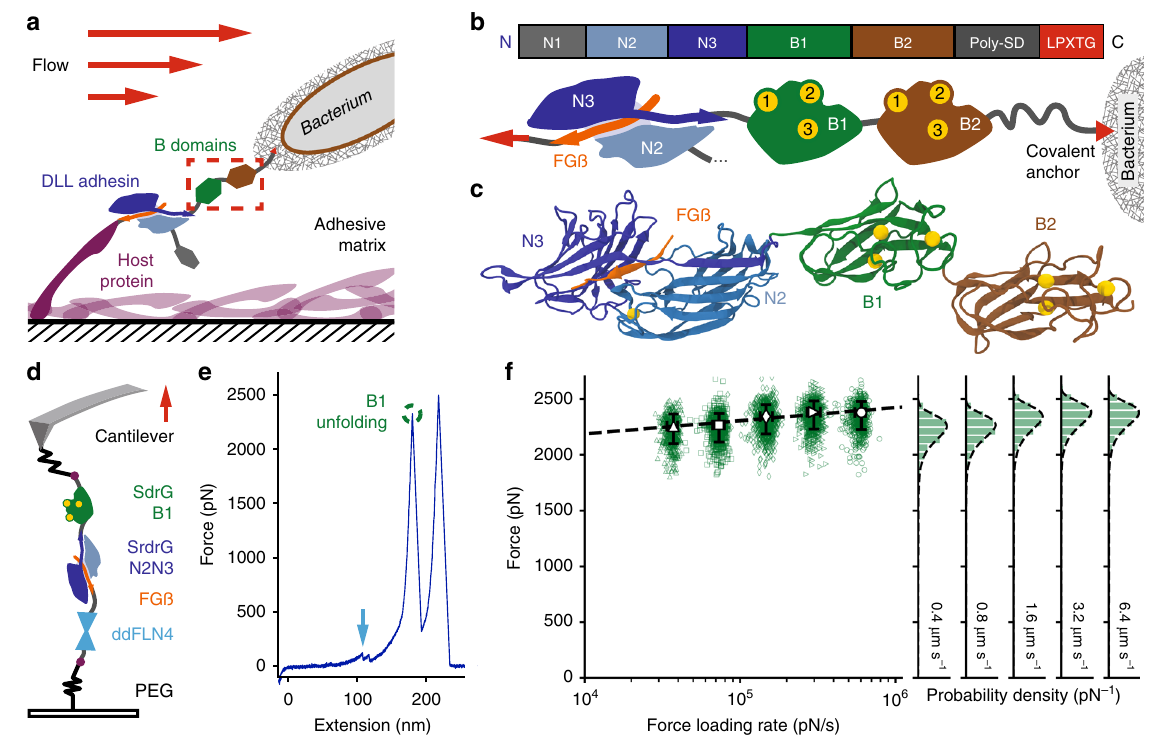
Fig. 1 Staphylococcal B domains are extremely resilient to mechanical force. a B domains, here from SdrG, are the link between the extremely strong interaction between the tip adhesin domain N2N3 (blues) binding a peptide (orange) presented by a host protein covering a surface (in this case fi brinogen, purple). b SdrG gene (top) and schematic (bottom): N-terminal N1 domain may be cleaved proteolytically, followed by the N2 and N3 domain that bind Fgß, B1 (green), and B2 (brown) each coordinate three Ca 2 + ions and connect to the SD repeat region that gives the adhesin its name. The adhesin is covalently anchored to the bacterium ’ s peptidoglycan via a sortase motif (red). c MD equilibrated structure of the SdrG N2N3 domains connected to the fully ß-sheet Ig-like folds of the B1 and B2 domain (modeled from the homolog SdrD B1), each B domain coordinates three Ca 2 + ions (yellow). d AFM-SMFS assay: covalent surface anchoring through polyethylene glycol (PEG) via the ybbr-tag (purple) using Fgß (orange)-ddFLN4 (cyan)-